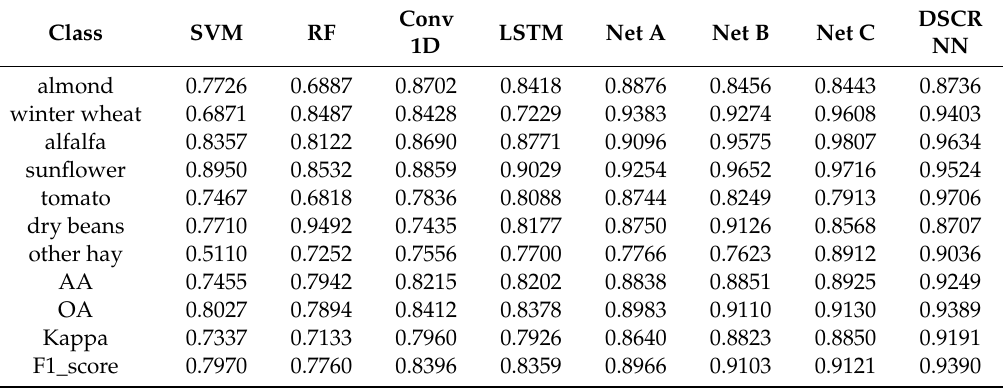
Table 5. Classification results of study area